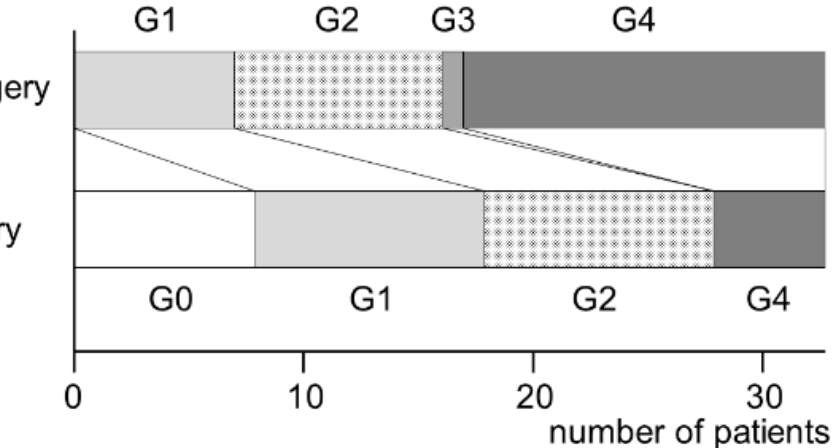
Figure 4. Treatment outcomes of maxillary sinusitis by initial grade.